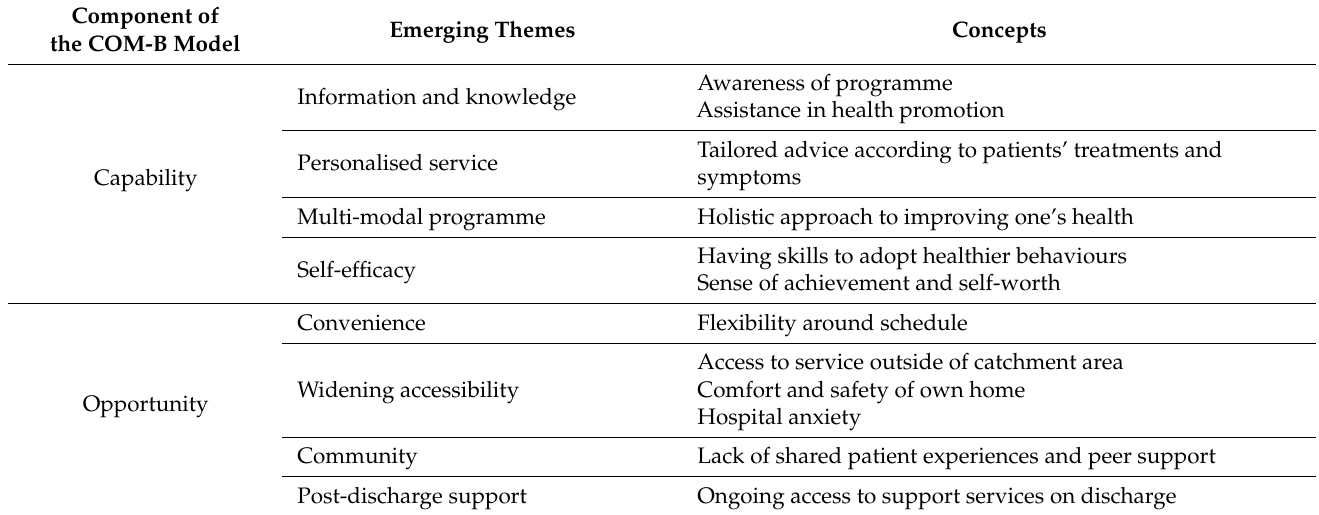
Table 3. Emerging themes generated from our